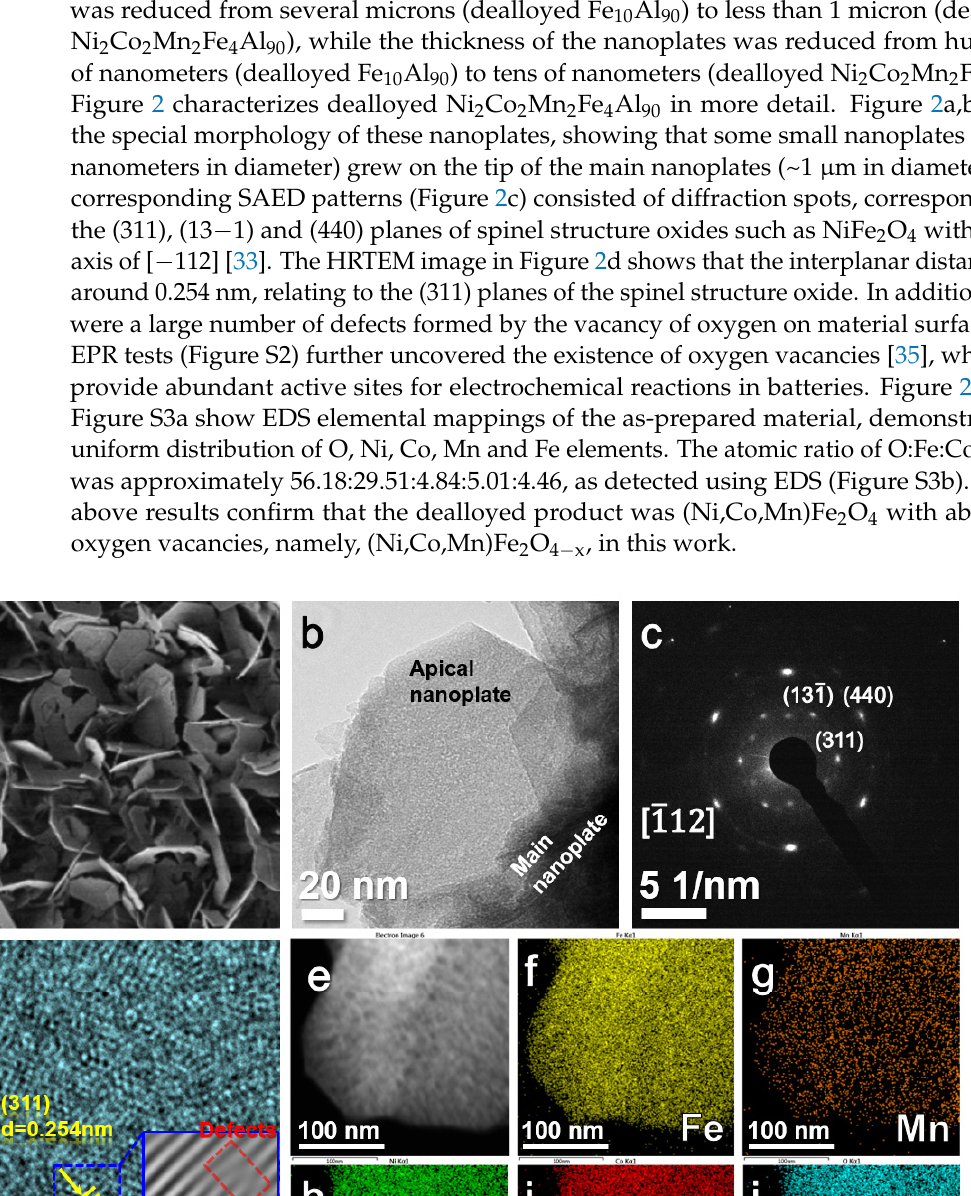
Figure 3. ( a ) XRD patterns of pristine NiCoMnFe 2 and dealloyed (Ni,Co,Mn)Fe 2 O 4 − x oxides. ( b – g ) XPS spectra of (Ni,Co,Mn)Fe 2 O 4 − x : ( b ) XPS survey spectra; ( c – g ) high-resolution core-level spectra of Fe 2p, Mn 2p, Ni 2p, Co 2p and O 1s, respectively.